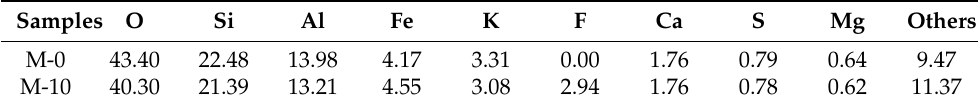
Figure 8. Pore size distribution (PSD) ( a ) of M-0, M-4 and M-10; XRD ( b ) and FTIR ( c ) of PVDF, M-0 and M-10. Table 1. XRF of M-0 and